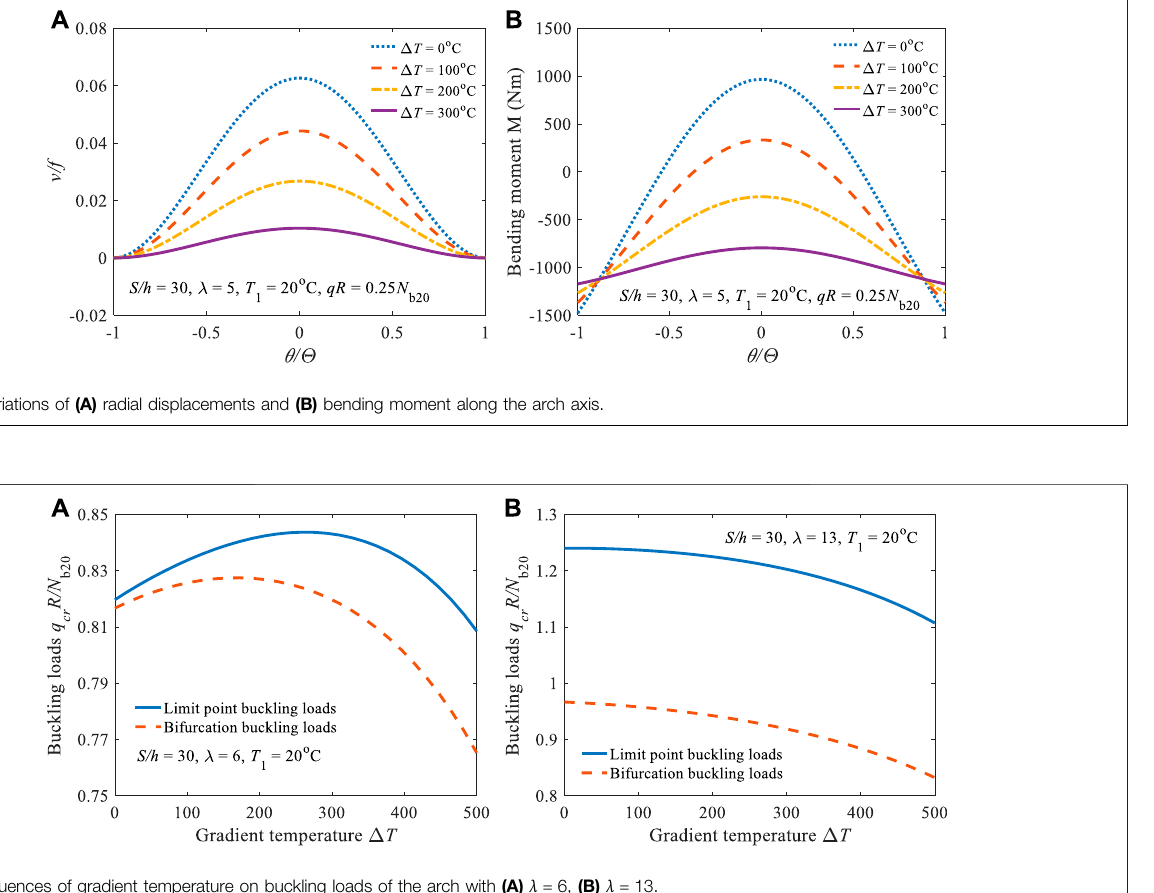
FIGURE 5 | In fl uences of gradient temperature on buckling loads of the arch with (A) λ (cid:1) 6, (B) λ (cid:1) 13.